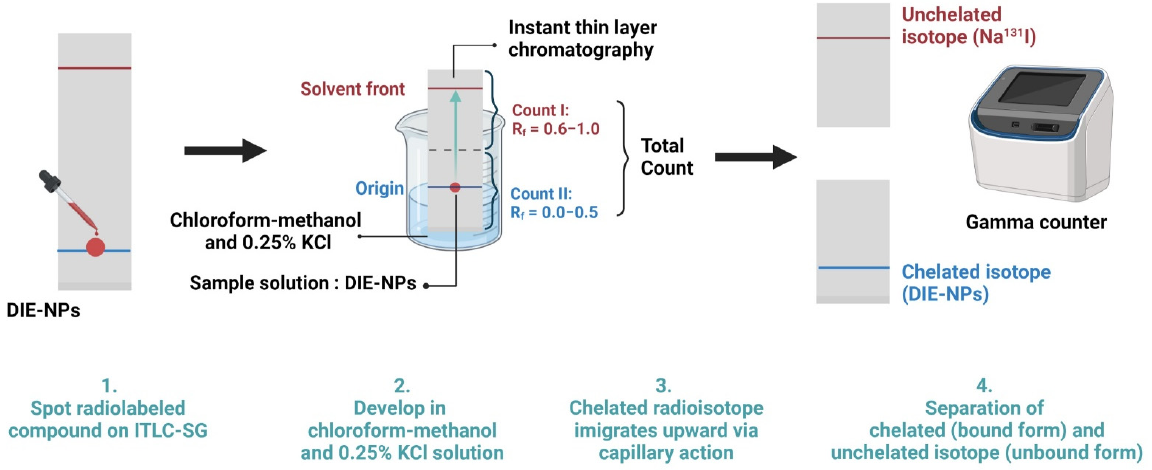
Figure 2. Radioactive labeling yield schematic. Instant thin-layer chromatography (ITLC) silica gel